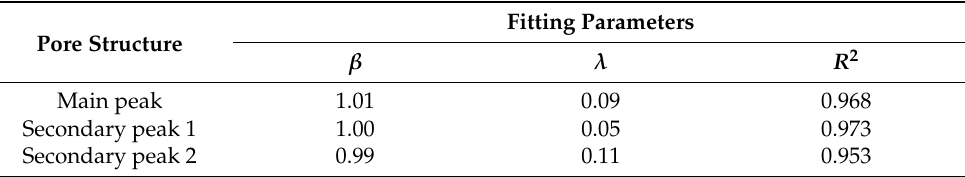
Figure 8. Fitting results of correlation model between mechanical properties of coarse-grained soil and pore structure. ( a ) main peak; ( b )secondary peak 1 ( c ) secondary peak 2. Table 8. Parameter values of correlation model fitting between mechanical properties of coarse-grained soil and pore structure.